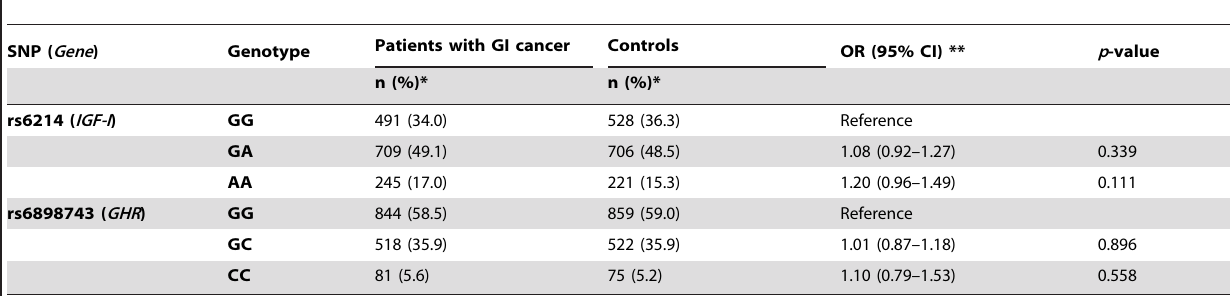
Table 3. Genotype distribution in patients with gastrointestinal cancer and